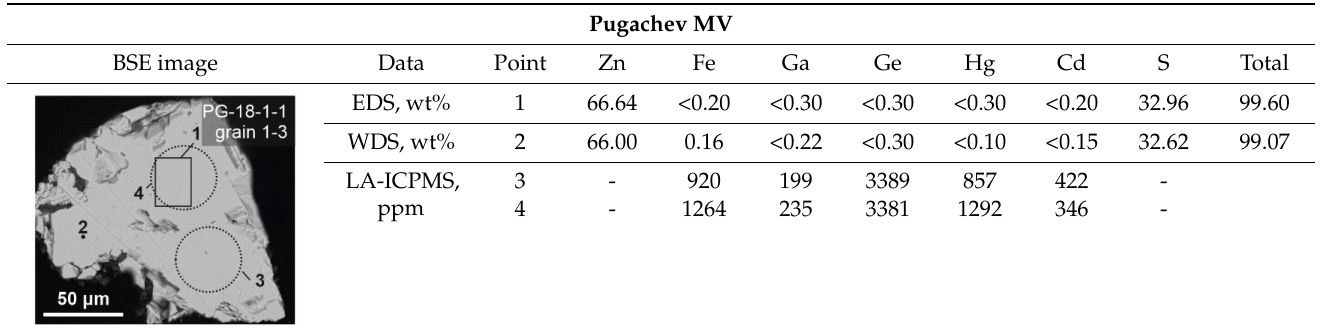
Table 6. Representative back-scattered electron (BSE) images and compositions of sphalerite with heterogenous Hg distribution; mud masses of Pugachev and South Sakhalin MVs, Sakhalin